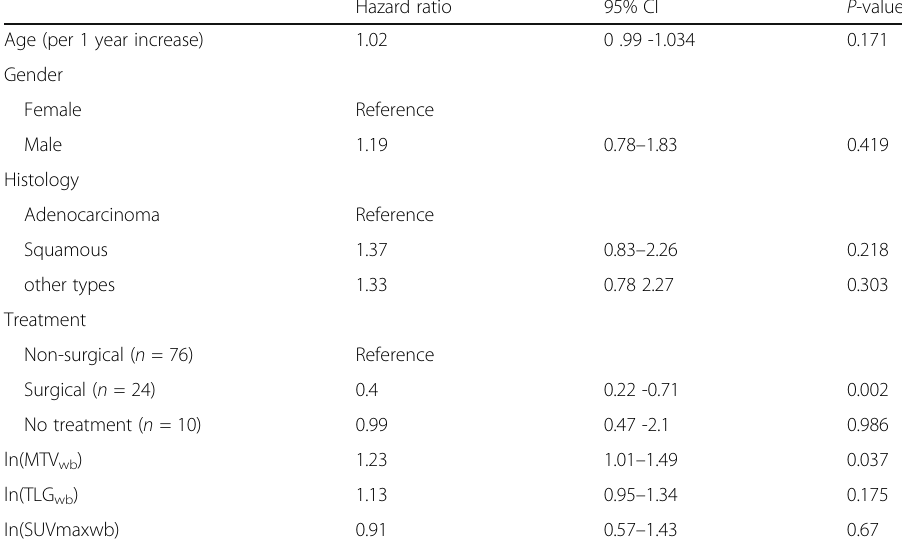
Table 2 Univariate Cox regression